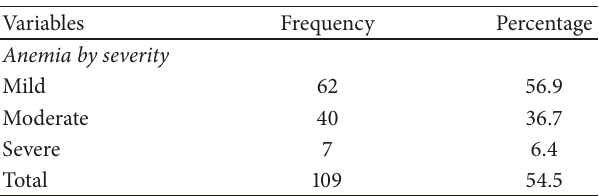
Table 3: Summary of anemia severity among anemic study partici- pants ( 𝑛 = 109 ).